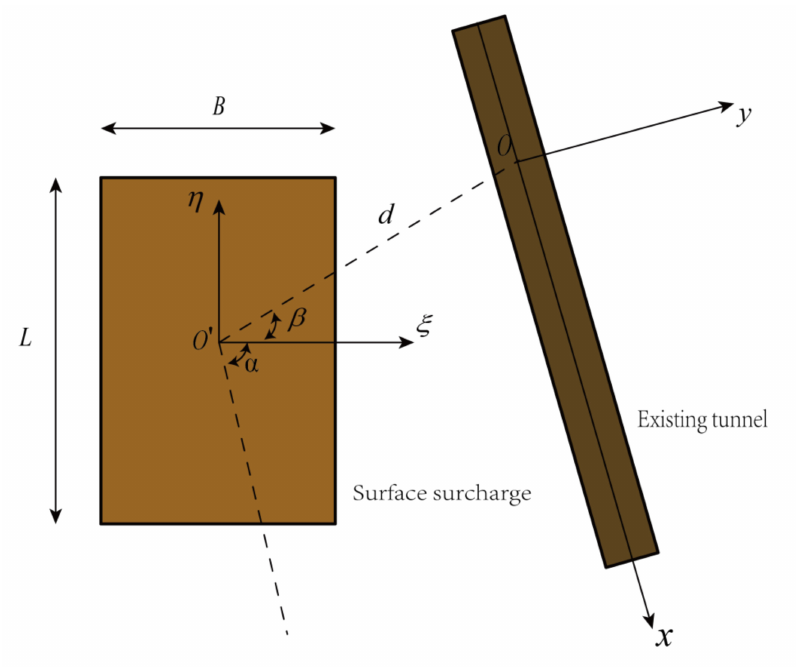
Figure 5. Coordinates between surface surcharge and the existing